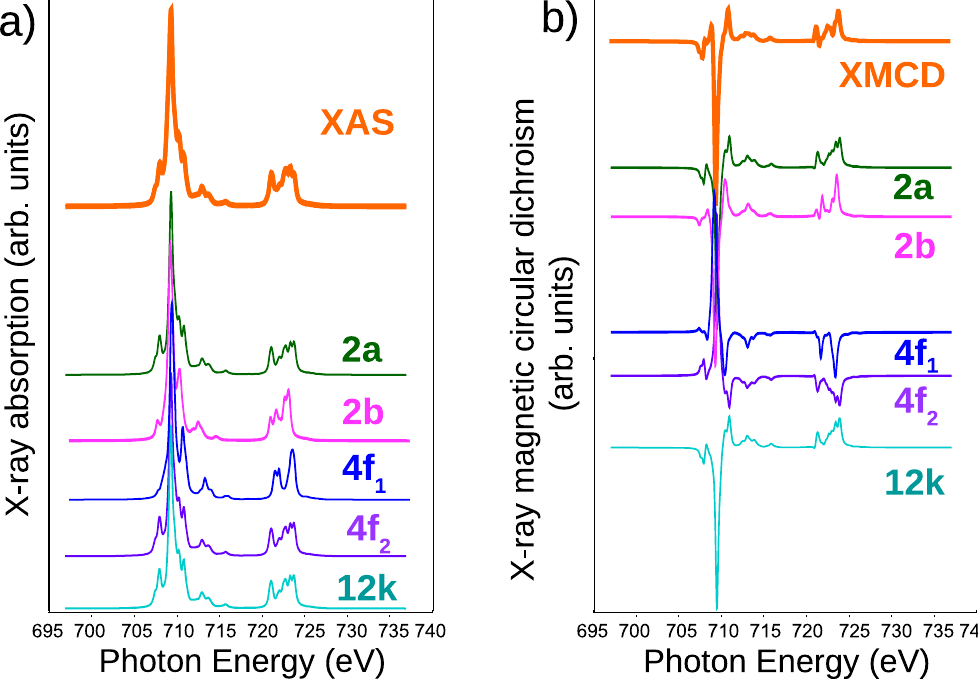
Figure 7. Atomic multiplet calculations used to simulate the XAS and XMCD spectra at the Fe L 2,3 absorption edges. For each iron cation, the XAS and XMCD spectra are calculated with the proper crystal field and we show on the top of each figure the sum of the sublattice